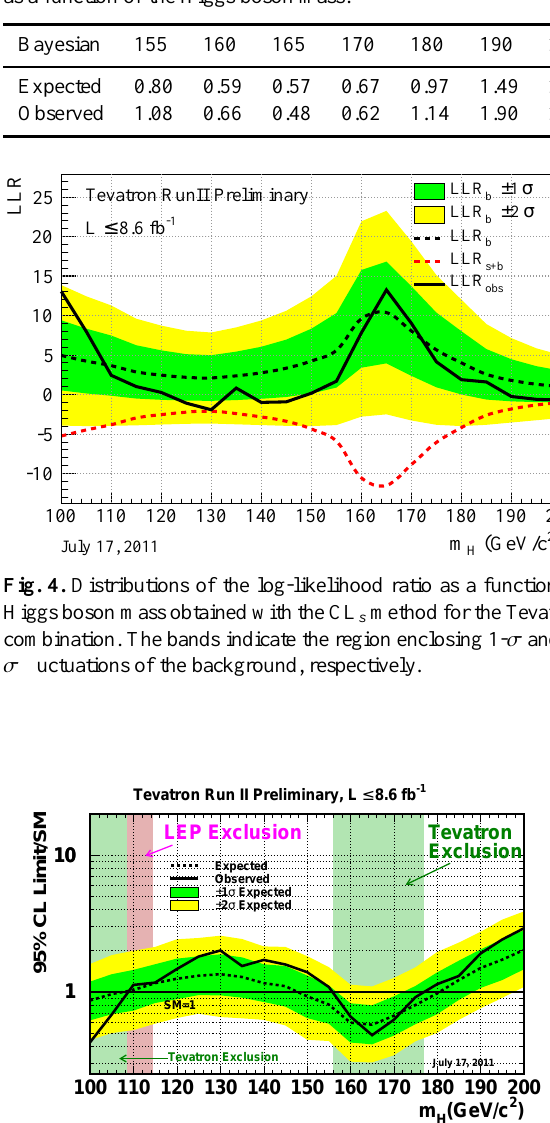
Fig. 5. Observed and expected 95% C.L. upper limits on the ratio to the SM prediction, as a function of the Higgs boson mass for the combined CDF and D0 analyses. The bands indicate the 68% and 95% probability regions where the limits can fluctuate, in the absence of signal.